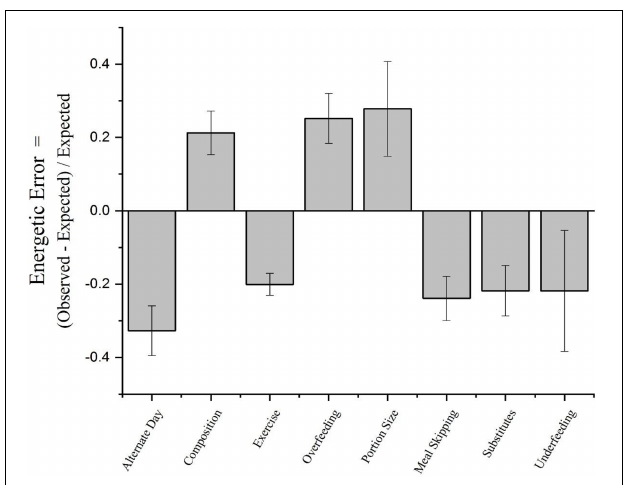
FIGURE 3 | Energetic errors imposed by various methods. From Levitsky et al.